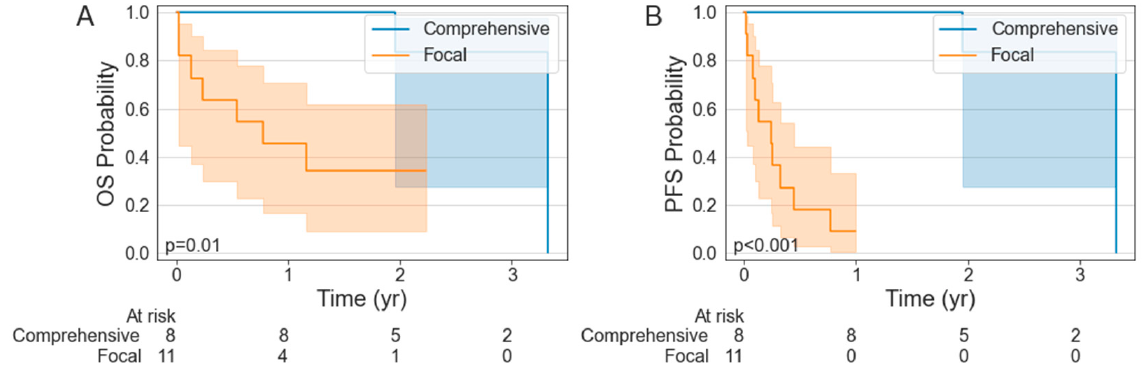
Figure 2. Kaplan–Meier estimates of overall survival ( A ) and progression-free survival ( B ) stratified by receipt of comprehensive versus focal bridging radiotherapy. Table 4. Patient and treatment characteristics of patients who underwent CAR T-cell therapy and bridging radiation stratified by extent of radiation volume coverage.